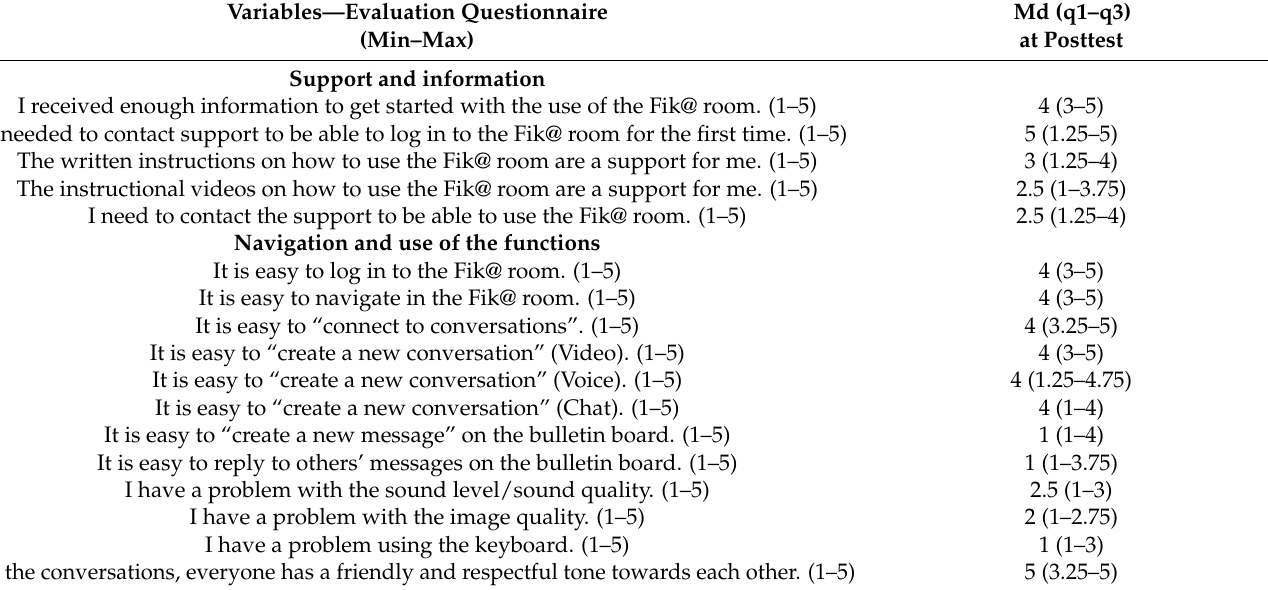
Table 5. Support and information, navigation and use of the functions at posttest ( n =